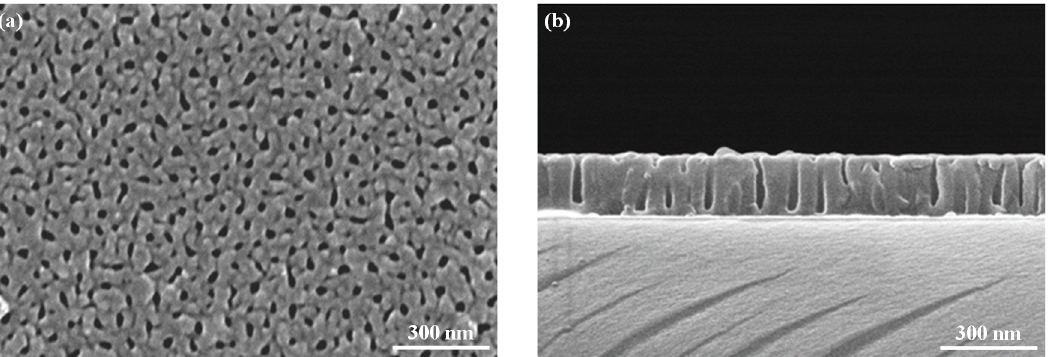
Figure 4. Scanning electron microscope (SEM) images of the AAO template: ( a ) top view; ( b ) cross-sectional view.